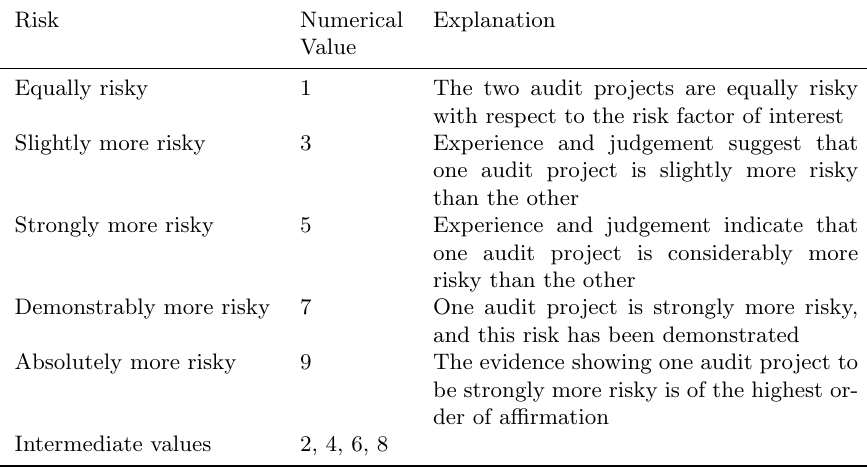
Table 1: Relative risks in audit projects (Patton et al .,